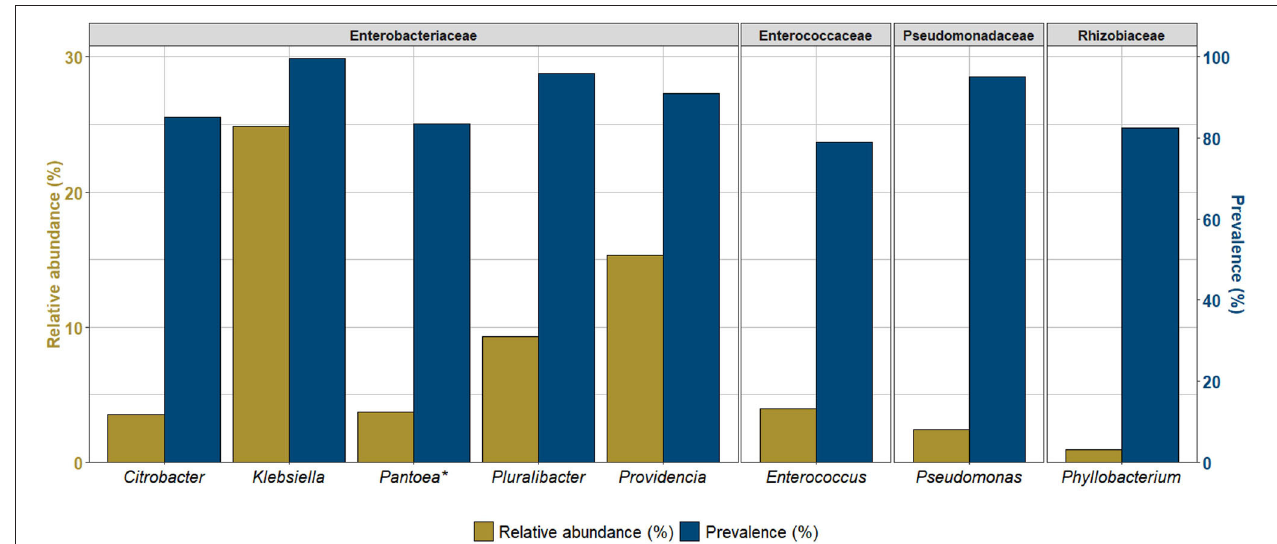
FIGURE 1 | Overall core bacterial taxa identified in at least 75% of the samples of Ceratitis capitata . Asterisk ( * ) represents genera identified in as two